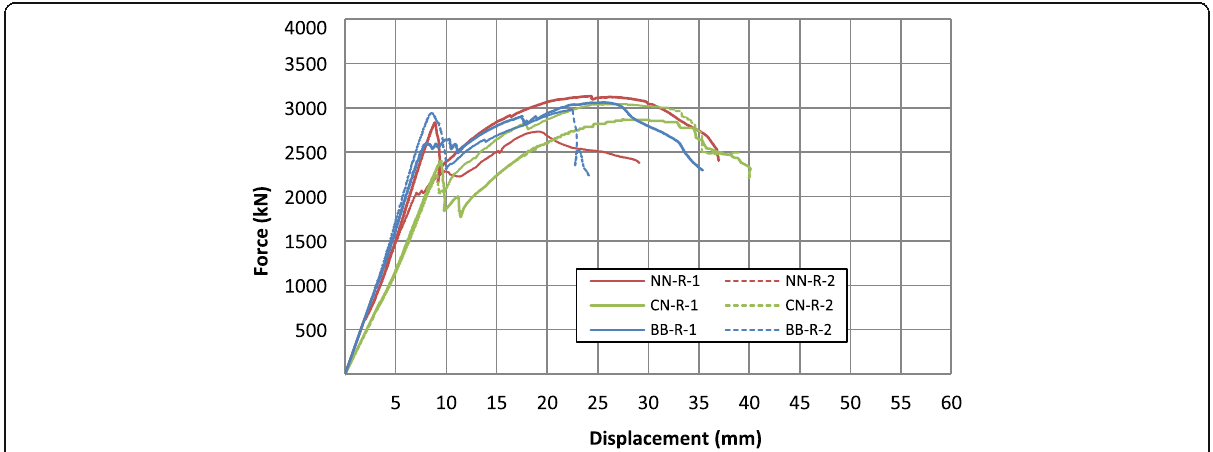
Fig. 10 Compression force versus axial displacement of corroded